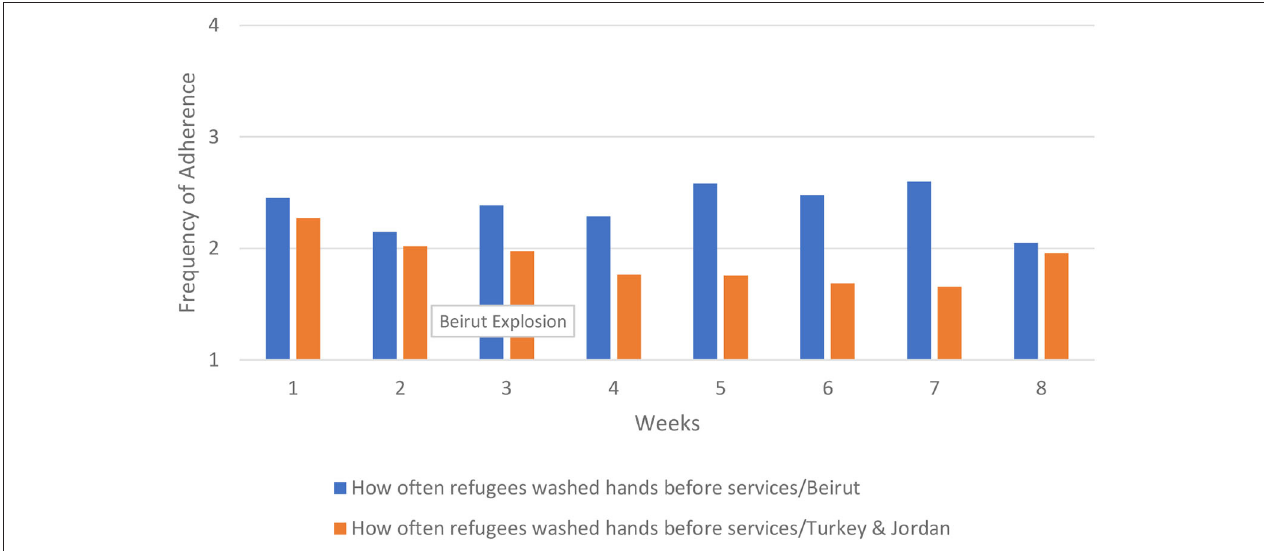
FIGURE 9 | How often refugees washed hands before services.